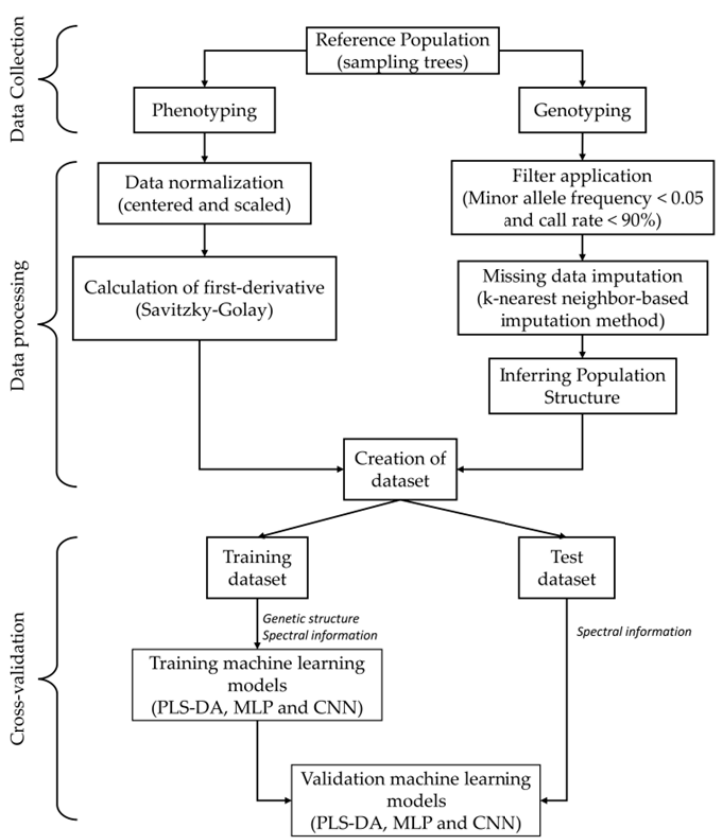
Figure 1. A comprehensive data processing workflow from data acquisition to model validation.